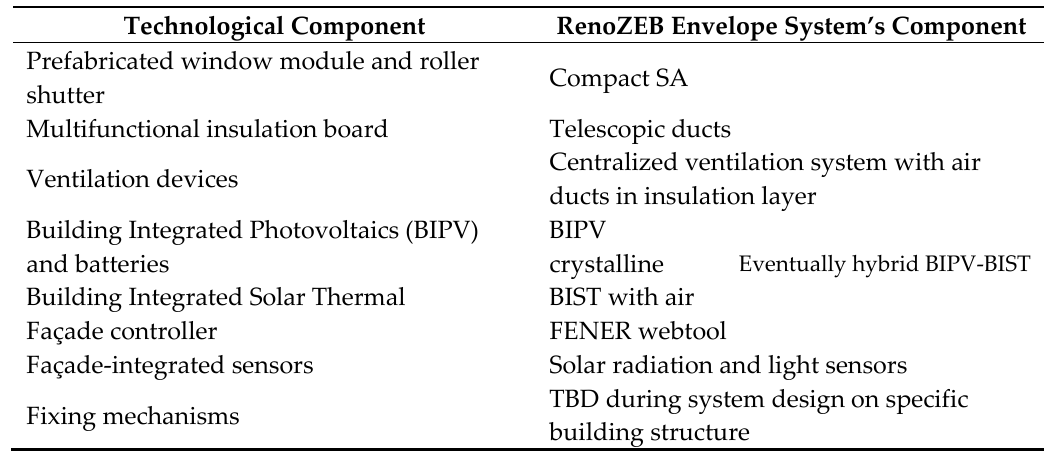
Table 2. Selection of the most suitable